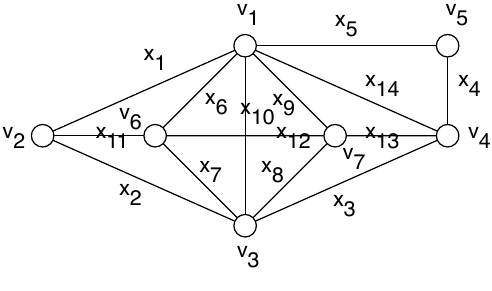
Figure 3: Graph G